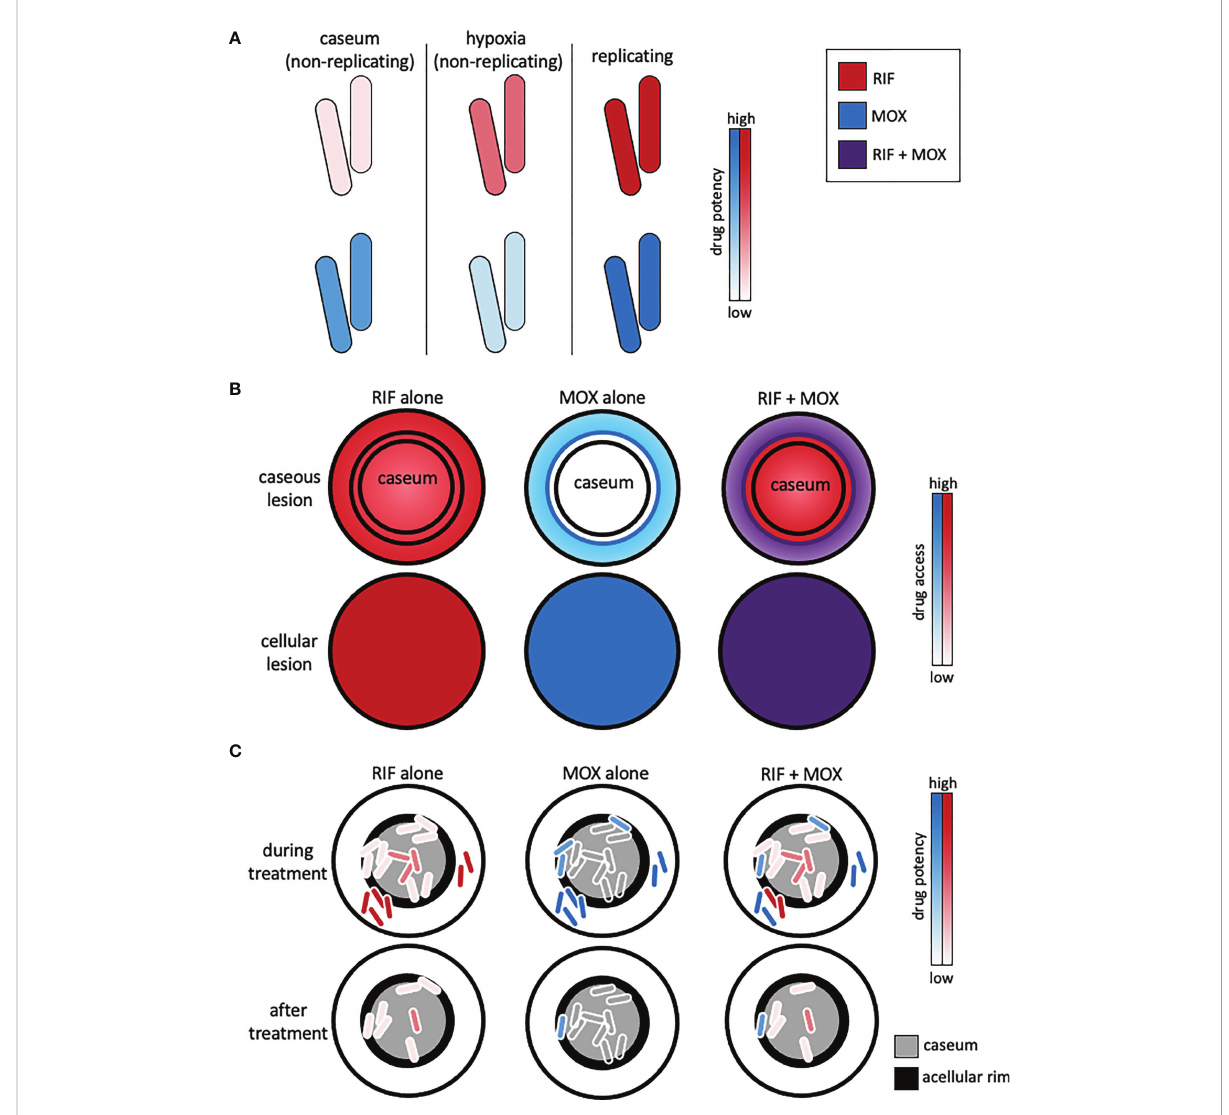
FIGURE 1 Representation of complex lesion pharmacokinetics and pharmacodynamics and how combination therapy must be optimized to reach different populations of drug-tolerant bacteria. (A) Drug pharmacodynamics are dependent on the bacterial state. Rifampicin (RIF) and moxi fl oxacin (MOX) exhibit different potencies against non-replicating intracaseum bacilli, non-replicating bacilli (e.g., induced by the Wayne hypoxia model), and replicating bacilli (e.g., in standard culture media). (B) Drug pharmacokinetics are lesion-dependent. Rifampicin (red) and moxi fl oxacin (blue) exhibit different levels of access to caseous lesions due to their drug-speci fi c pharmacokinetic pro fi les. Inner concentric circles represent the acellular rim of caseous lesions. Drug combinations (e.g., RIF + MOX, purple) can overcome the pharmacokinetic limitations of single drugs. (C) Mtb that evade treatment and cause relapse are mainly found in the acellular rim (black) of caseum and in caseum. Drug combinations should be chosen to capitalize on pharmacokinetic and pharmacodynamic properties such that they access all the bacteria and kill the different types of drug-tolerant bacteria induced by the microenvironments in those